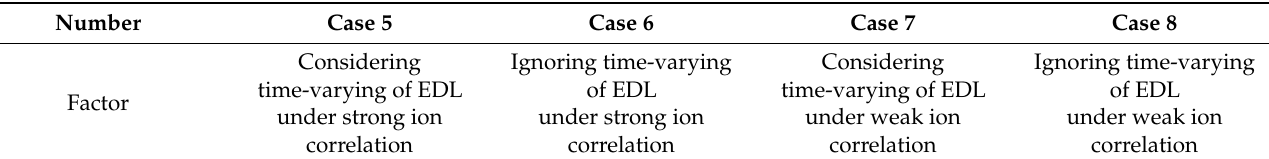
Table 5. Factors considered in different cases.